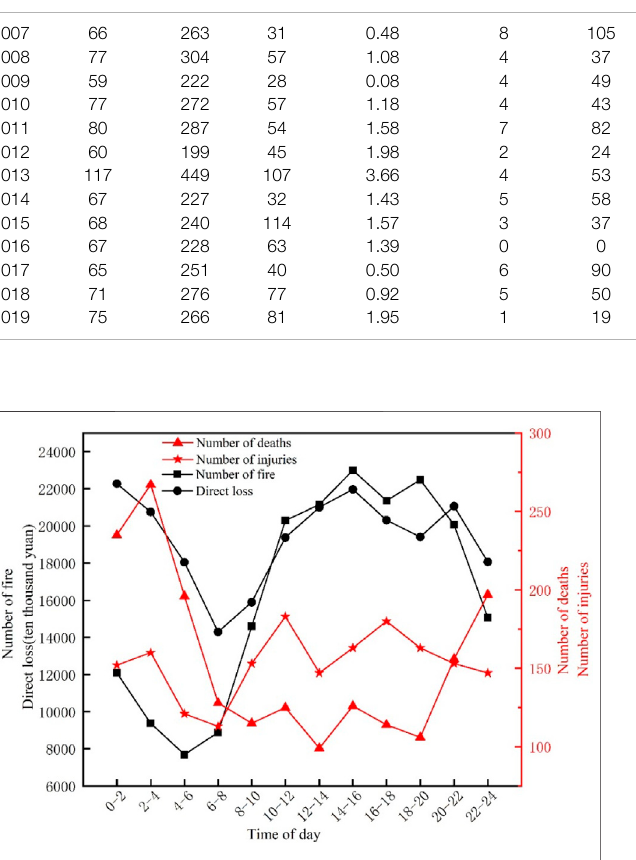
FIGURE 5 | Four indicators of fi re at different times of the day.